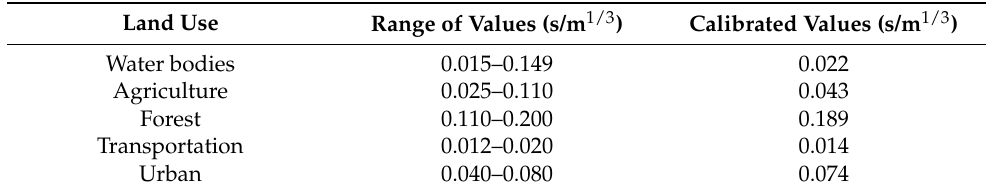
Table 1. Manning coefficient values based on Bhola et al. [8]